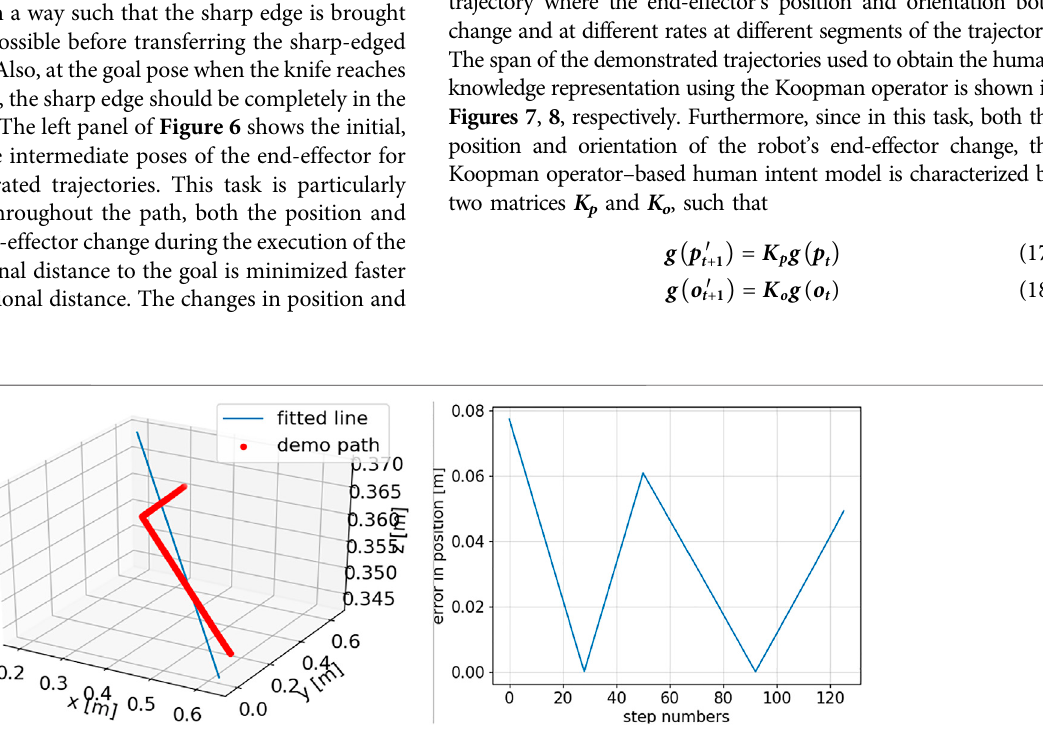
Frontiers in Robotics and AI |